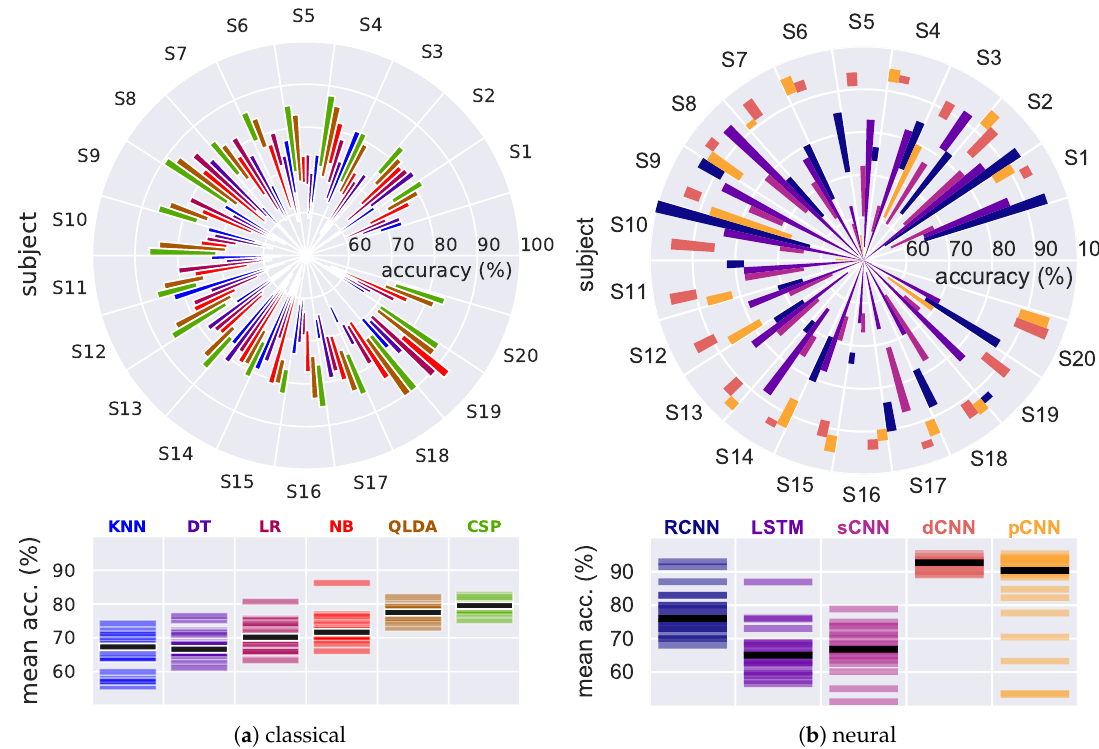
Figure 5. MI classification accuracies from 20 subjects using ( a ) traditional machine learning approaches and ( b ) different neural classifiers. The polar bar plot shows the accuracy range (mean ± standard deviation) achieved by the 5 models for each of the 20 subjects. The lower panel subsumes for each algorithm the 20 mean accuracies achieved, black bars indicate the median